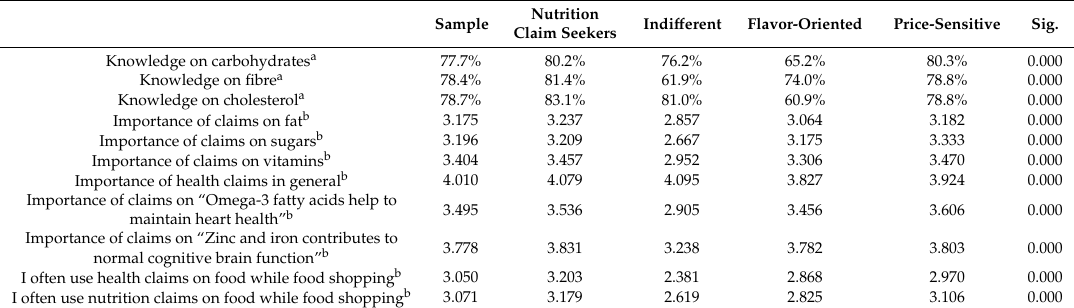
Table 6. Knowledge, attitude, and use of nutrition and health